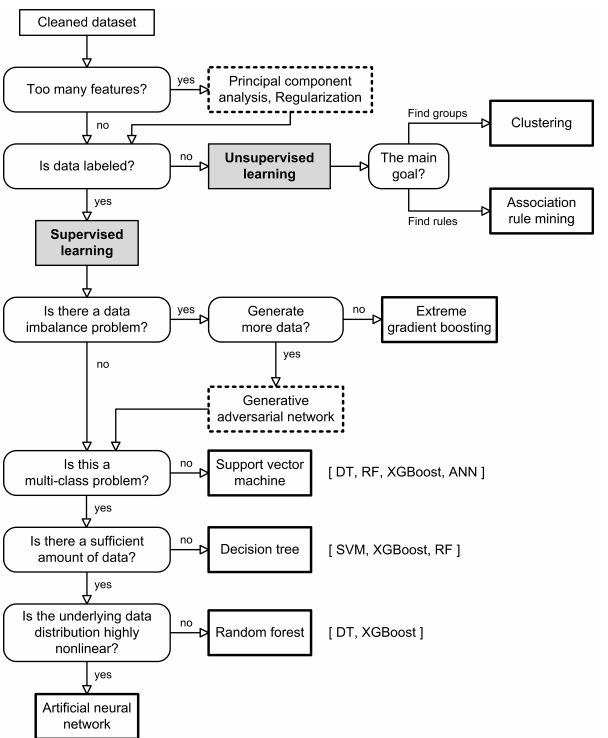
Figure 9. A diagram depicting the process of developing an FDD system, to help with choosing appropriate modeling techniques. Alternative techniques to those recommended are presented in square